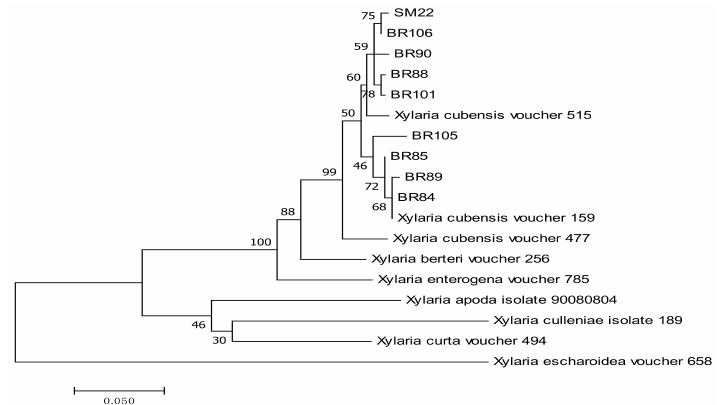
Figure 5. Maximum likelihood tree inferred from combined sequences of β -tubulin and ACT of X. cubensis from C. castaneus spines with bootstrap values higher than 50% are shown next to the branches.